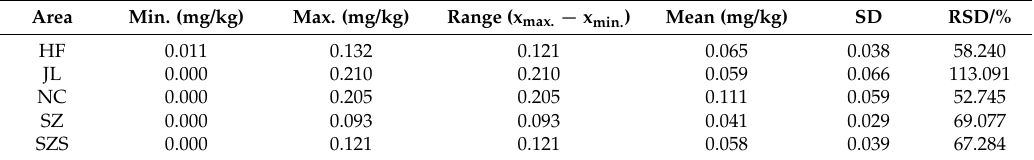
Table 5. Cadmium concentration in rice grain samples of different geographical origins by XRF.